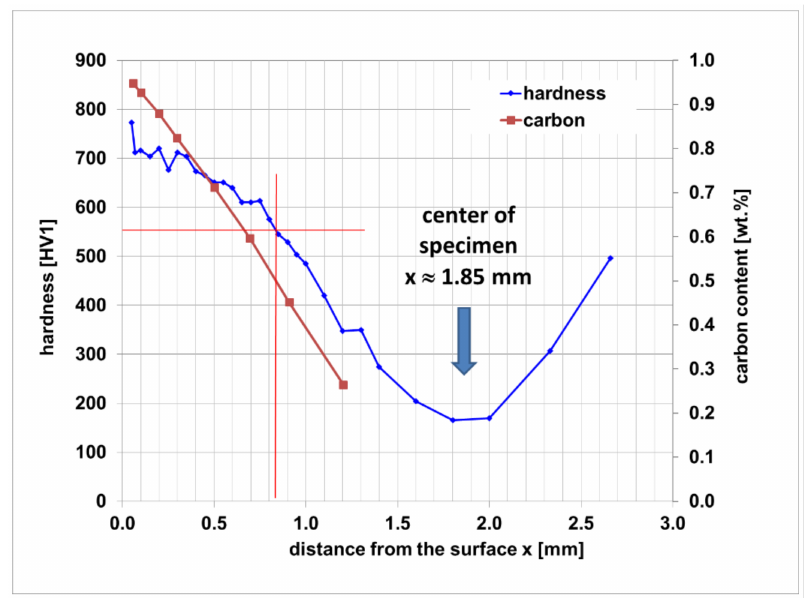
Figure 5. Hardness (HV1) and carbon content profile of the carburized sample without hol- low